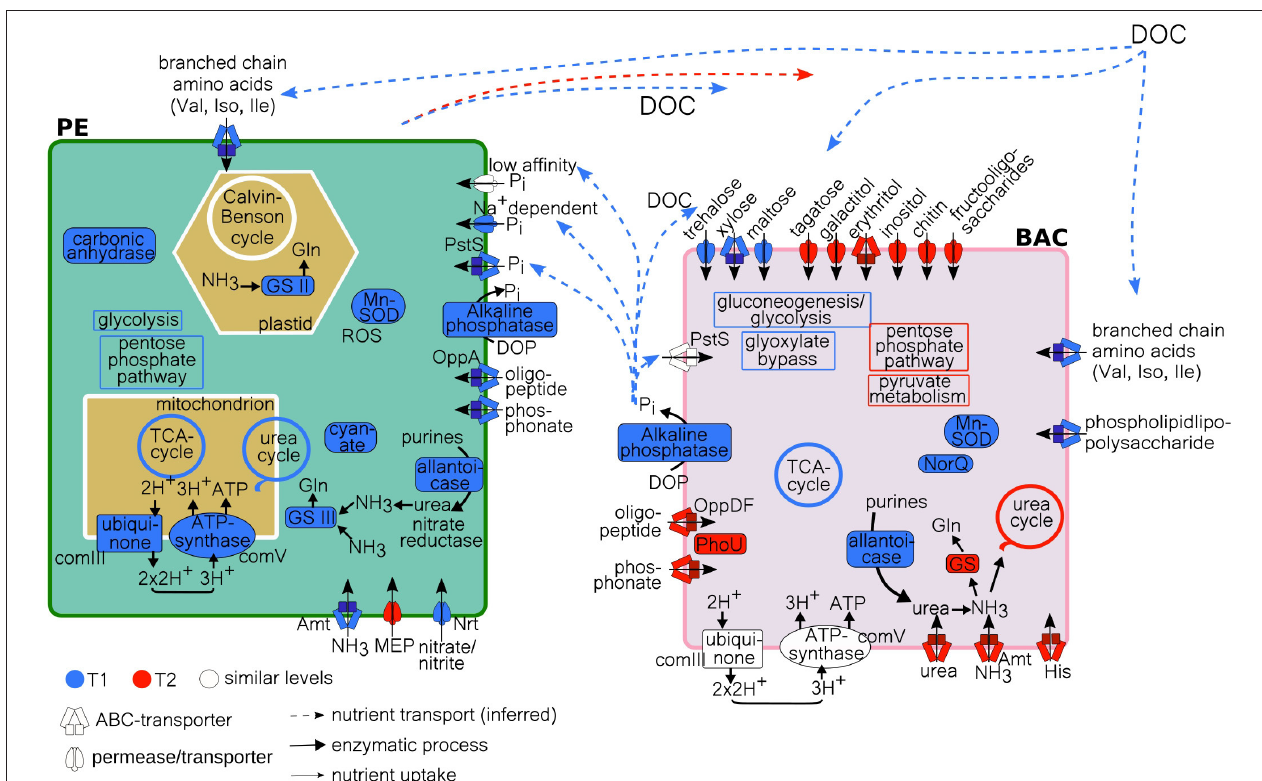
FIGURE 8 | Model of PE and BAC C, N, and P processes at T1 and T2, with inferred nutrient transport of DOC and Pi, based on metatranscriptome data analysis. Uptake/transport by either high-affinity ABC-transporters, low-affinity transporters or permeases. Processes more highly expressed at T1 (blue), at T2 (red), or at similar levels (white), according to TPM (PE) and absolute counts (BAC) ( Supplementary Tables 4, 6 ). GS, glutamine synthetase; MEP , methylammonium permease; DOC, dissolved organic carbon (allochtonous and autochtonous); Gln, glutamine; complex III and V, of oxidative phosphorylation/electron transport chain; Gln, glycine; Val, valine; Leu, leucine; Ile, isoleucine; His, histidine; ROS, reactive oxygen species; Mn-SOD, manganese sodium dismutase; NorQ, nitric oxide reductase Q; PE , planktonic eukaryotes; BAC ,